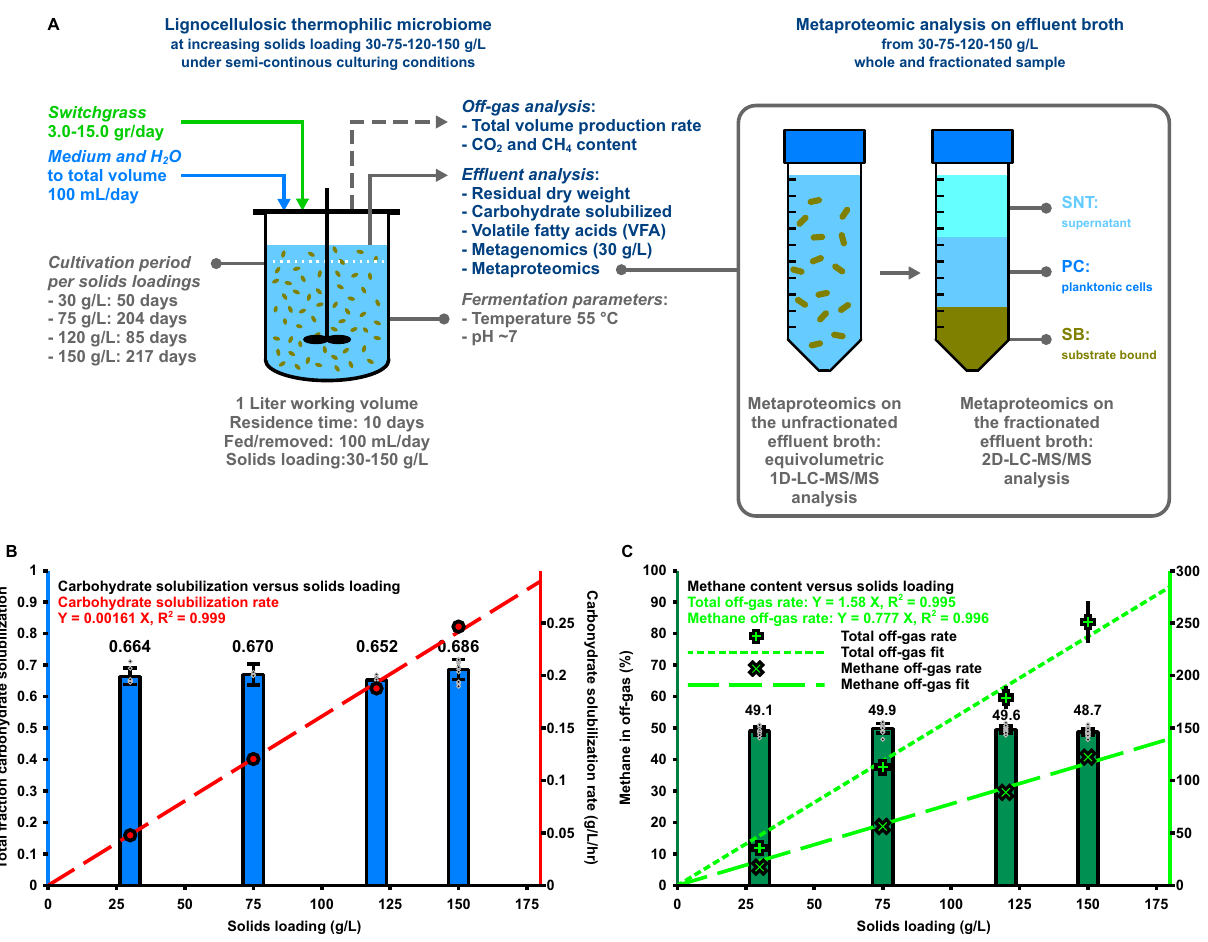
Fig. 1 An anaerobic thermophilic microbiome exhibits undiminished fractional carbohydrate solubilization with increasing solids loadings between 30 and 150 g/L. A Experimental overview. A lignocellulose-fermenting microbiome was fed semi-continuously with increasing amounts of switchgrass. Samples were analyzed for carbohydrate solubilization and metaproteomics. Metaproteomic analysis was carried out two ways; whole sample analysis (1D LC-MS/MS) and sample fractionation followed by multidimensional (2D LC-MS/MS) analysis. Prior to multidimensional measurements, each sample was separated by centrifugation into supernatant (SNT), planktonic cells (PC), and substrate bound (SB) fractions. B Stable carbohydrate solubilization (blue bars) at ~66.8% was obtained, with the rate of substrate solubilization (red circles) increasing linearly with solids loading. Data for 30 g/L was partially published prior in 44 . The data represents average values for different time-points during steady-state conditions for one microbiome (see Supplementary Table 2), error bars represent ± one standard deviation. The individual data points for total fractional carbohydrate solubilization (blue bars) are shown as dots (black circles) for each solids loading. The carbohydrate solubilization rate linear fi t line (red dashed line) is based on carbohydrate solubilization rate data (red circles), which is calculated from fractional solubilization data (blue bars) adjusted for residence time in hours, the total carbohydrate content of switchgrass and the switchgrass loading concentration (30, 75, 120, and 150 g/L respectively). C The methane content of the off-gas (dark green bars) was constant, with the rate of off-gas (light green plus-shaped markers) and methane production (light green crosses) increasing in proportion to solids loading. Data for 30 g/L was partially published prior. Data points for methane content and off-gas production rate are averages for different time-points during steady-state conditions for one microbiome (see Supplementary Table 2), all error bars represent ± one standard deviation. The individual data points for methane concentration in the off-gas (dark green bars) are shown as dots (black circles) for each solids loading. Methane off-gas rate data is based on methane concentration in the off-gas and the off-gas production rate. Fit lines for the off-gas production rate (light green dashed line) and the methane off-gas production rate (light green dotted line) are linearly fi tted to the data. Source data are provided as a Source Data fi